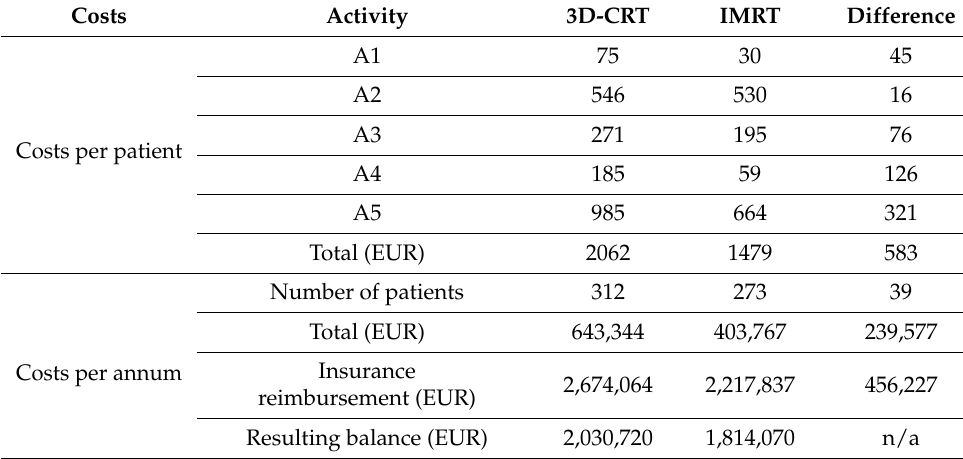
Table 13. The resulting 3D-CRT and IMRT costs balance and insurance reimbursements related to the C61 diagnosis.